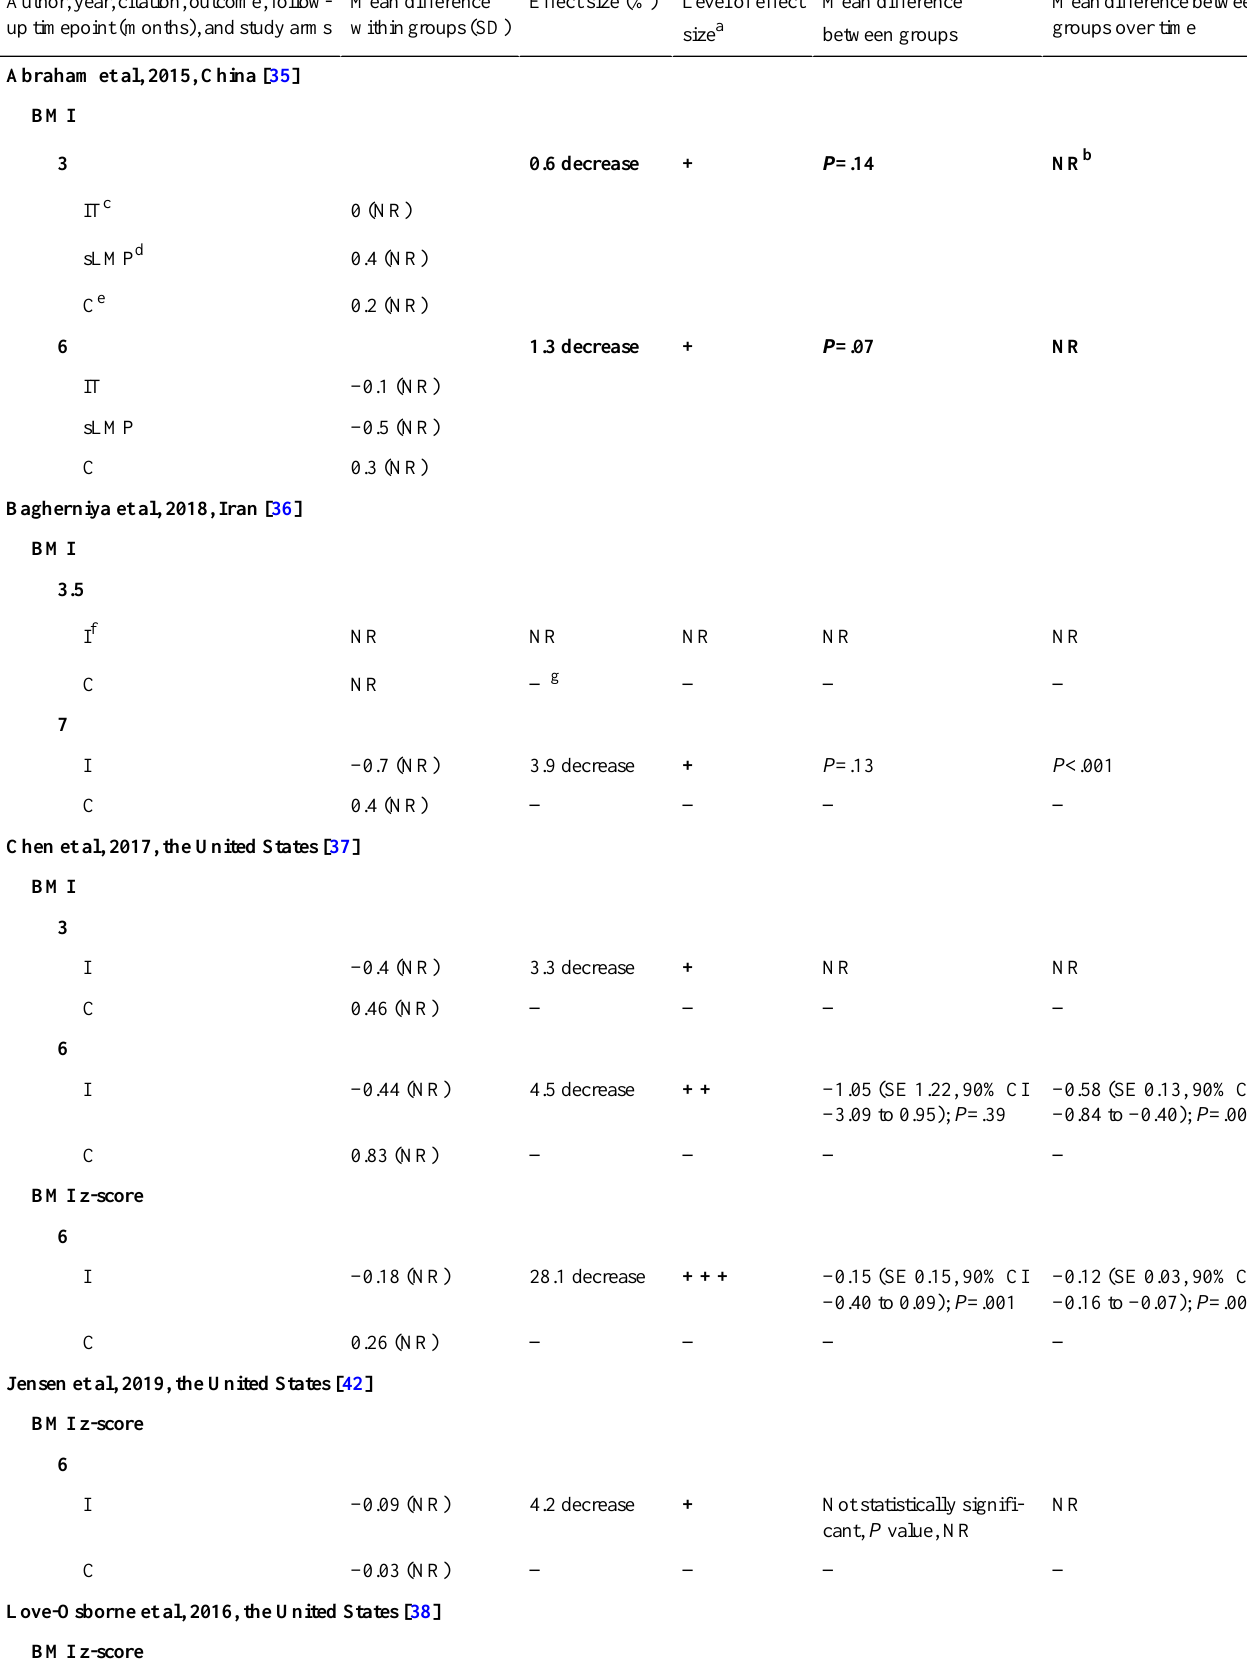
Mean difference